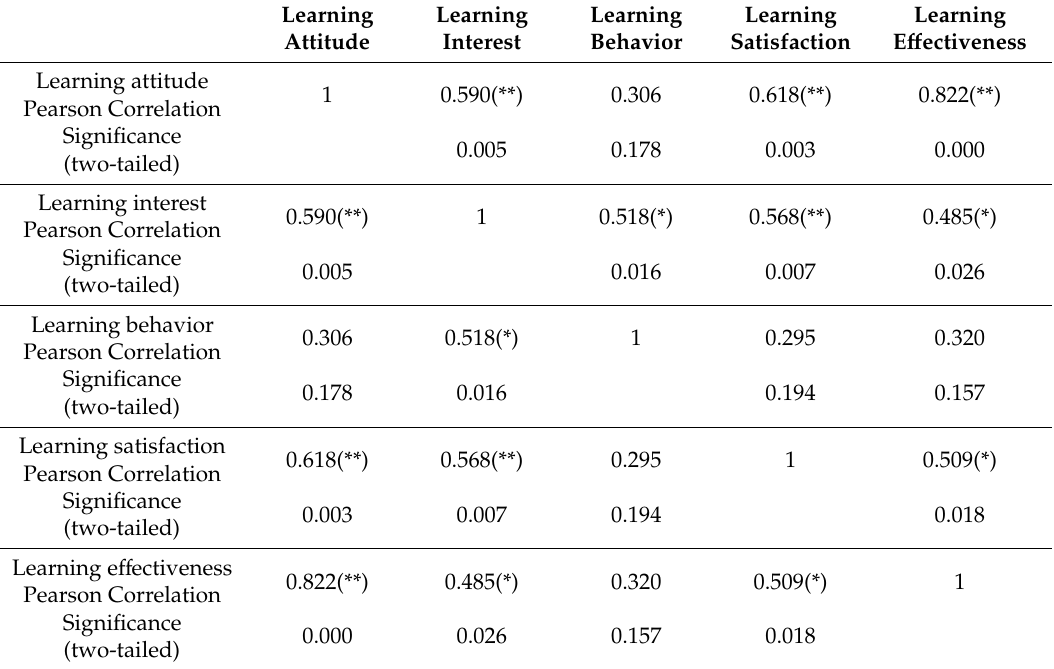
Table 7. Correlation